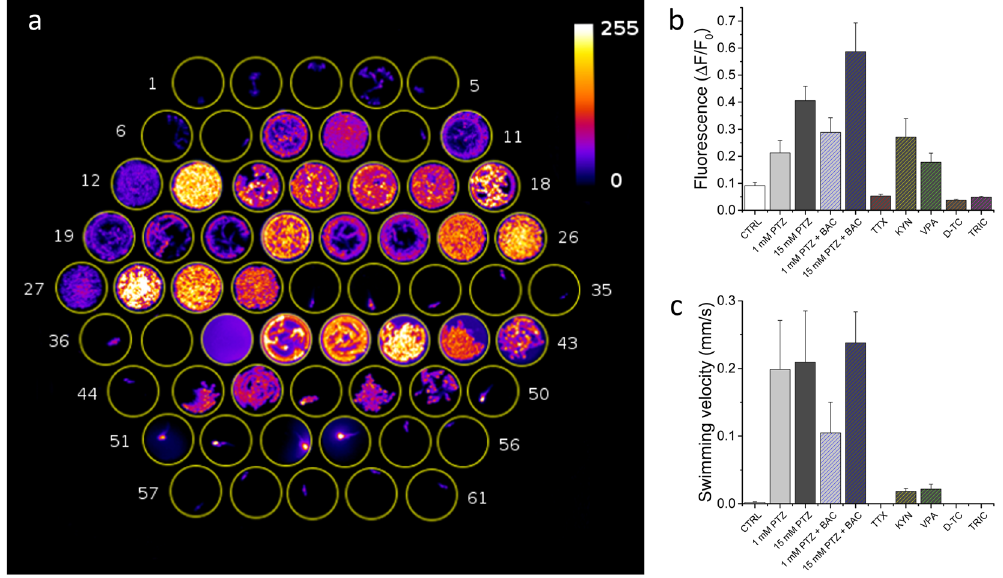
Figure 6. High-throughput combined fluorescence and behavioural assay. ( a ) Maximum intensity projection of a 13 minute segment of the recording. Well content: 1–6 control, 7–12 1 mM PTZ, 13–18 15 mM PTZ,